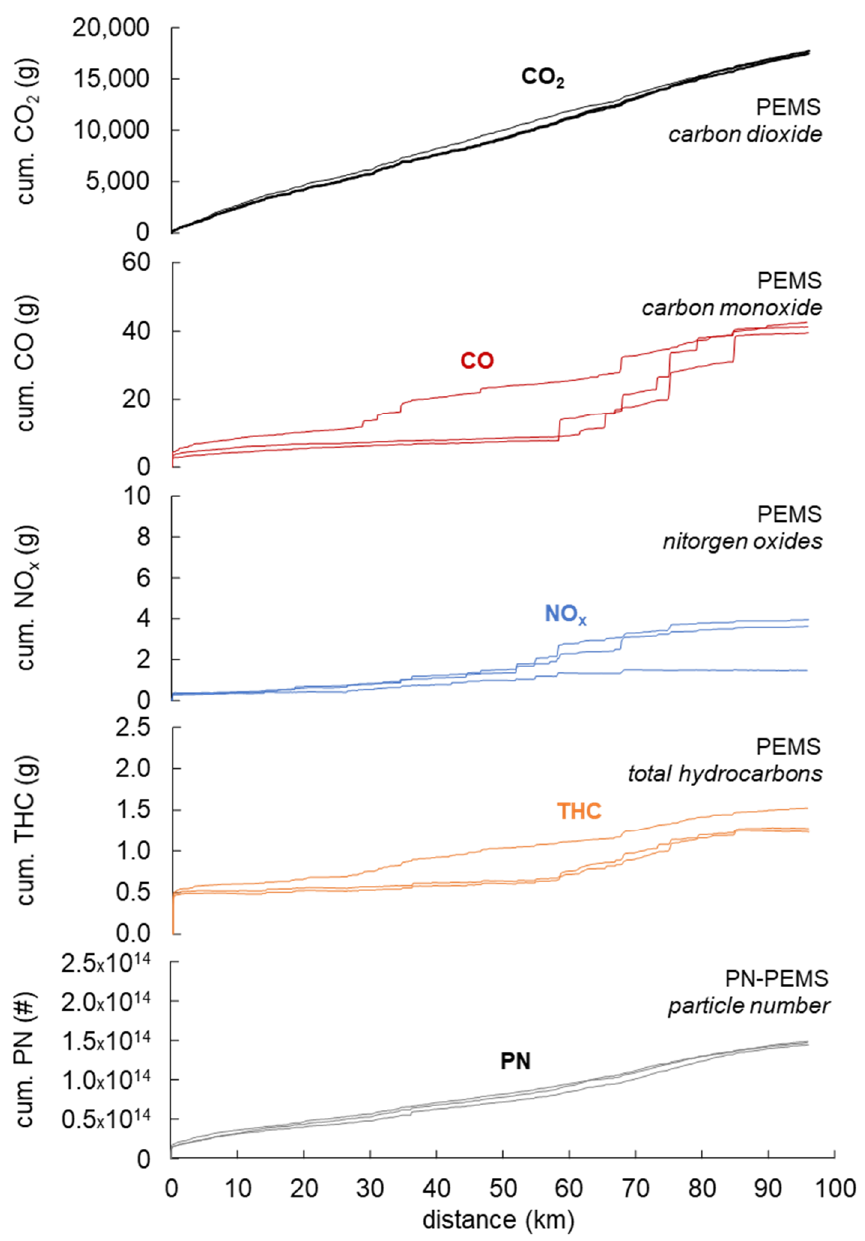
Figure 1. Example of cumulated emissions in winter, official RDE route, vehicle 1, gasoline.